Question: What visual encoding does this figure use to show its data?
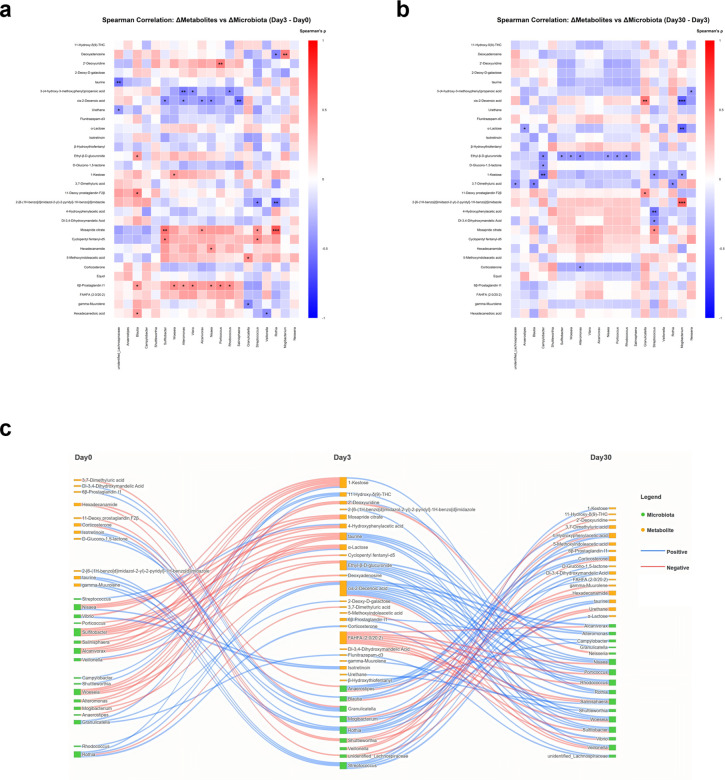
Answer: heatmap